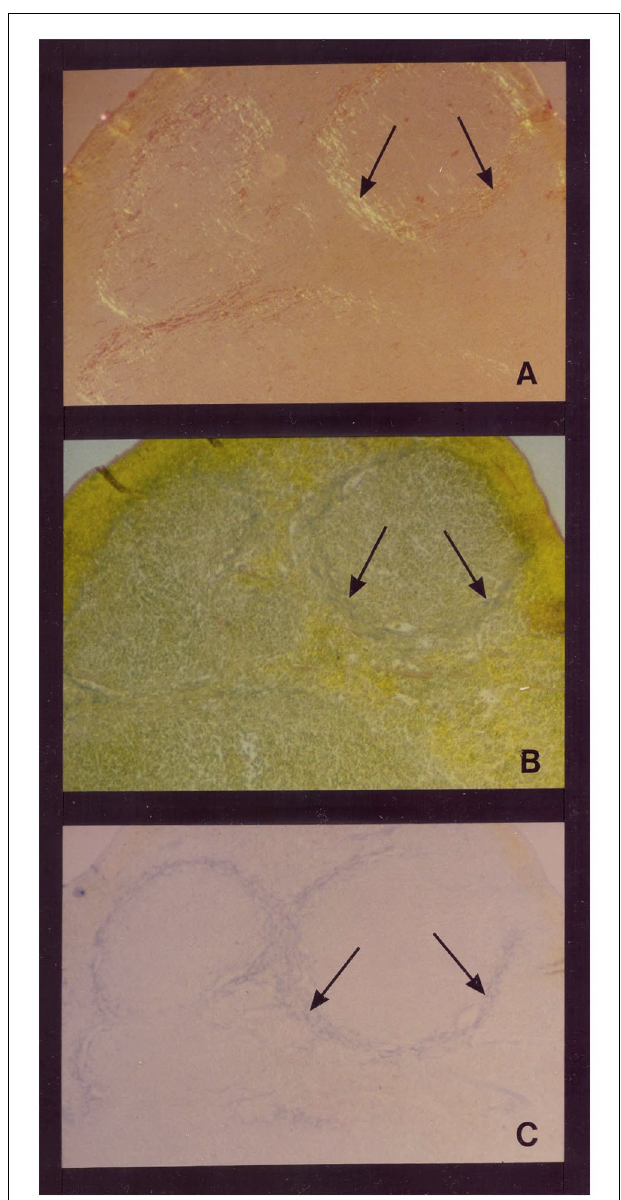
FIGURE 1 | Temporal relationship between AA amyloid deposition and heparan sulfate glycosaminoglycan (GAG) accumulation in the spleen in a mouse model of experimental AA amyloidosis. AA amyloid deposition and sulfated GAG deposition in the perifollicular areas of spleen at 48 h post-induction (with amyloid enhancing factor + silver nitrate (Snow, 1986). (A) Splenic amyloid (arrowheads) has extended to most perifollicular areas. Congo red staining for amyloid deposits under polarized light. (B) Positive Sulfated Alcian-Blue (SAB; arrowheads) seen in the exact perifollicular areas as amyloid deposits. (C) Positive Alcian blue staining at 0.7 M magnesium chloride demonstrating accumulation of primarily highly sulfated GAGs at amyloid deposition (Snow,